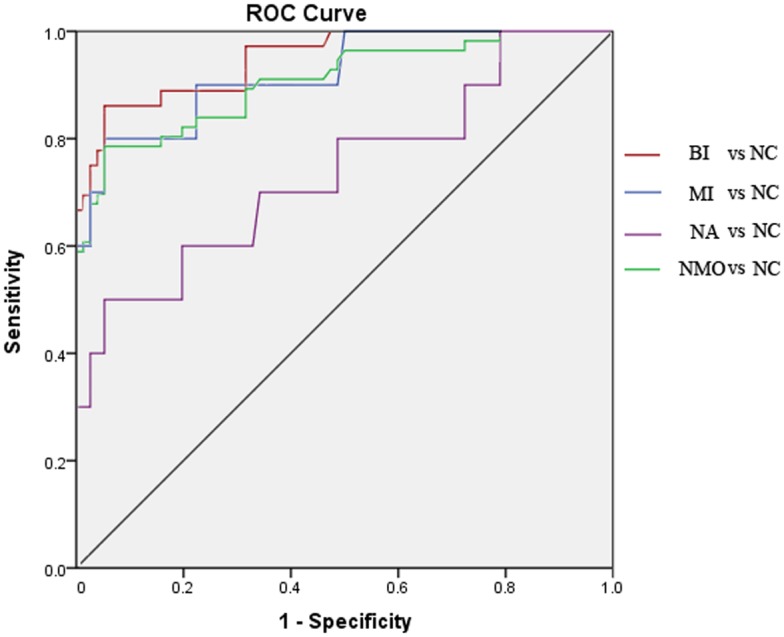
ROC curves of comparisons of FA values for the whole intraorbital optic nerve among the NMO subgroups and normal controls.The AUC (0.95) and sensitivity (86%) in BI vs. NC were larger than those in the other subgroup comparisons. (BI, biocular impairment; MI, monocular impairment; NA, normal-appearing; NC, normal control; AUC, area under the curve).